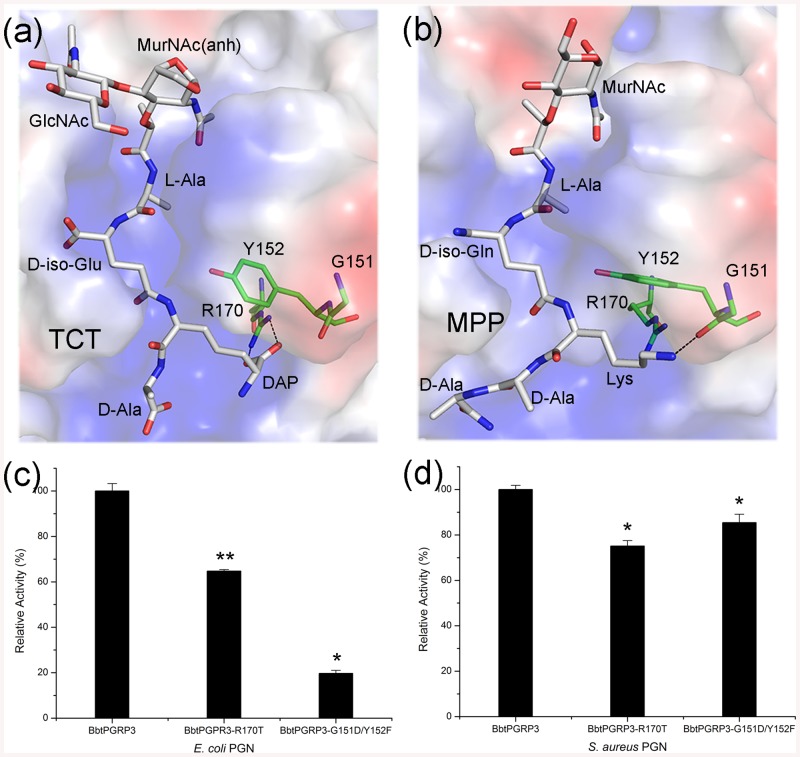
The G/Y/R motif and amidase activity.Docking models of (a) TCT or (b) MPP binding to the PGRP domain. TCT and MPP are colored in white, whereas the interacting residues are colored in green. Reactions containing RBB-labeled (c) E. coli PGNs or (d) S. aureus PGNs were incubated with wild-type BbtPGRP3, the R170T and G151D/Y152F mutants, respectively. Undigested PGNs were pelleted by centrifugation and the absorbance of the supernatants at 595 nm were determined. Results of activity are expressed as the percentage to the wild-type. The values are expressed as mean values ± SD of three independent experiments. All data were analyzed by t-test, and the statistical significance of the differences between experimental and a control group is shown with asterisks (*P<0.01, **P<0.005).